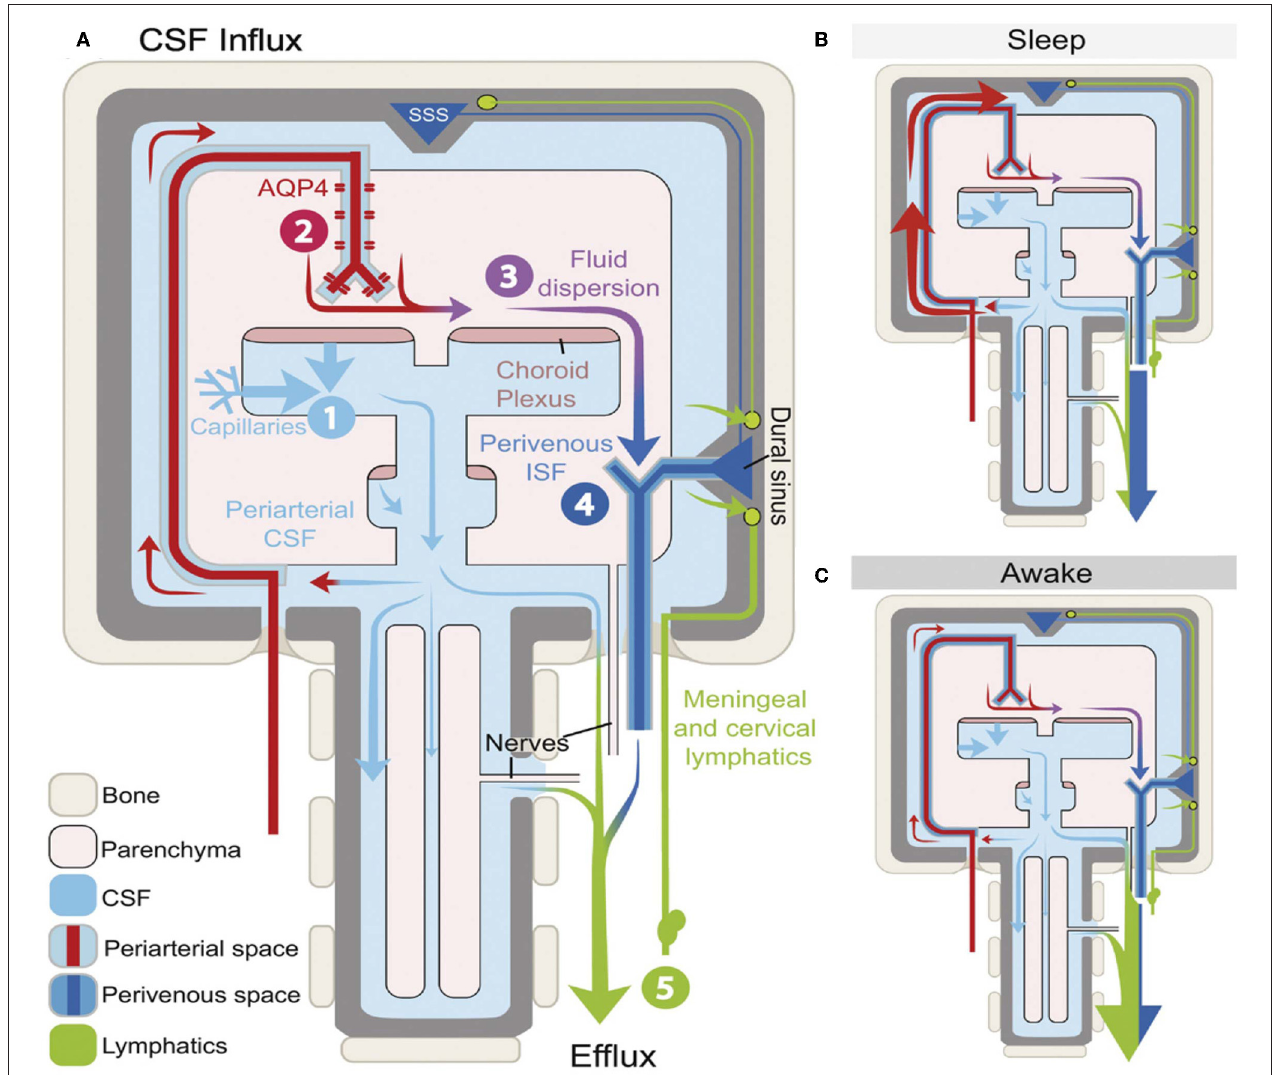
FIGURE 3 | Schematic outline of glymphatic system (GS) function during different arousal states (64). The influx and efflux of the fluid transport pathway from GS (A) and its function varies during different arousal states. A glymphatic clearance occurs primarily during sleep via the enlargement of the periarterial space and the perivenous space to promote the glymphatic flow (B) . However, function decreasing in the GS results in the accumulation of metabolic waste, which builds up in the awake brain and mostly depends on lymphatic vessels to exclude (C)